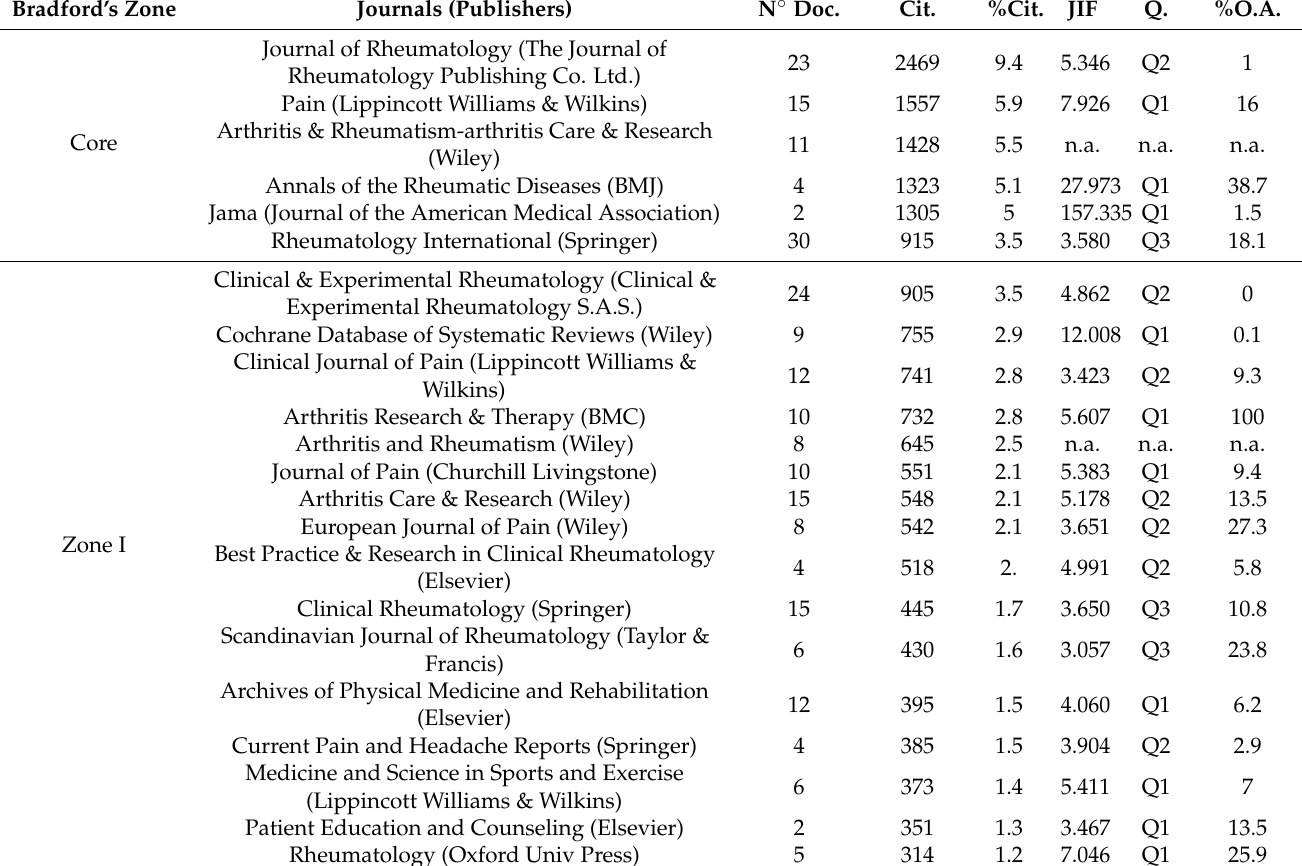
Table 2. Bradford’s Core and Zone 1 journals according to the number of